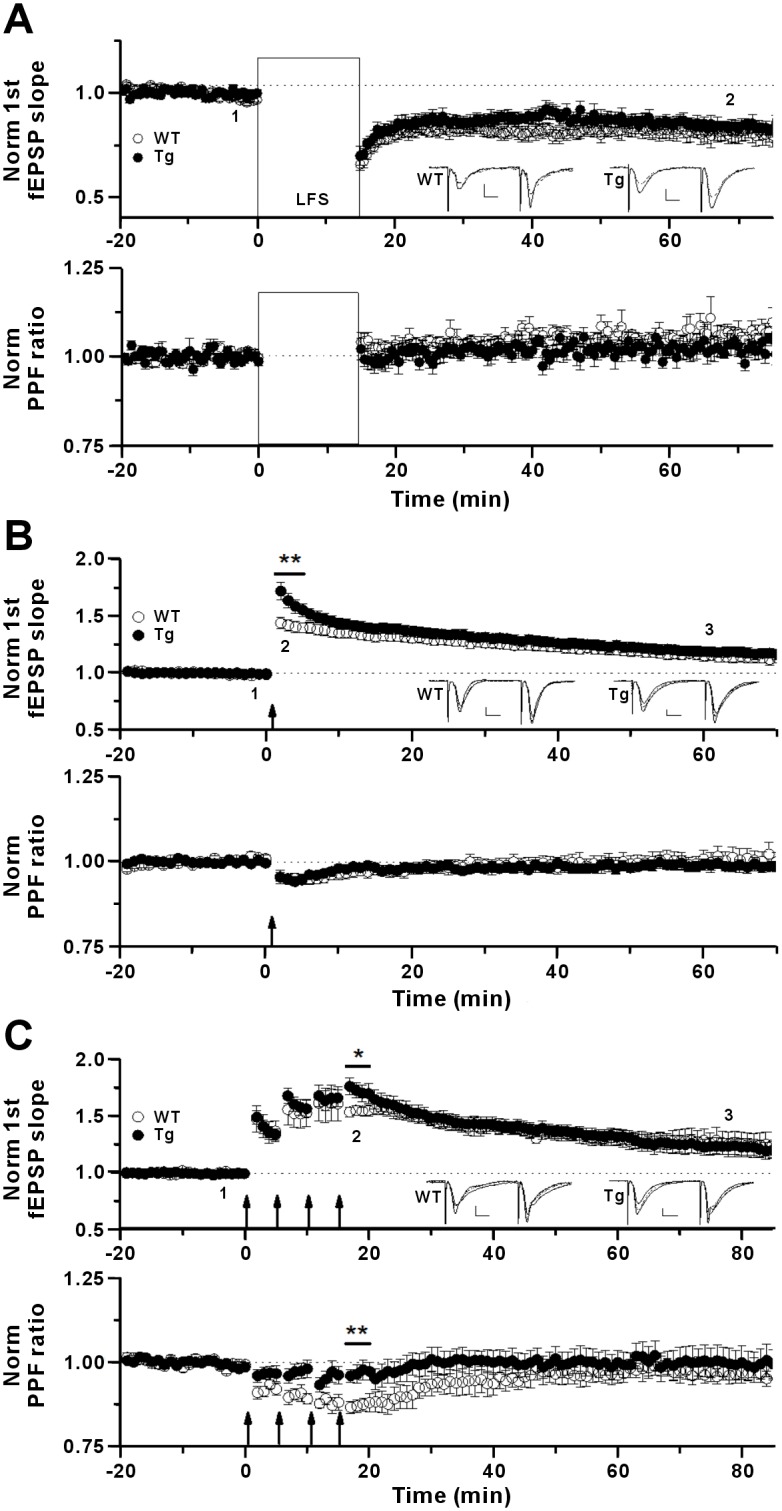
Normal fEPSP-LTD and transient increment of early LTP in young IP3K-A Tg mice.(A), LFS-induced LTD. Upper plot, LTD was induced by LFS protocol (1 Hz, 900 pulses) at the CA1 dendritic region of the hippocampal slice. The slope of fEPSP was 81.1 ± 1.5% (WT, n = 10 slices, 4 mice) and 84.0 ± 1.0% (Tg, n = 10, 4) at 60–65 min on the time axis (p = 0.11). Inlet traces are sample traces measured at baseline (1, thin line) and at 65 min (2, dashed line), respectively. Scale bars: 0.5 mV, 8 msec. Lower plot shows the normalized PPF ratio of the fEPSP slopes. PPF was measured at 60 to 65 min after induction of LTD (WT, 1.06 ± 0.80E-2; Tg, 1.02 ± 0.79E-2). (B), Single theta-burst induced LTP. Upper plot, LTP was induced with a single theta-burst protocol. Significant difference was observed immediately for 2–6 min after the theta-burst protocol (2, bar): WT, 141.5 ± 2.1%, n = 15; Tg, 160.6 ± 2.8%, n = 20; **p < 0.001. At 58–62 min (3), WT, 115.9 ± 2.0%; Tg, 118.9 ± 1.9% of baseline; p = 0.28. Inlet traces are sample traces indicating baseline (1, thin line), early peak (2, thick line) and late phase (3, dashed line). Scale bars for all sample traces: 0.5 mV, 8 msec. Lower plot shows the normalized PPF ratio of the fEPSP slopes. At 2–6 min, WT, 0.95 ± 0.62E-2; Tg, 0.95 ± 0.60E-2. At 58–62min, WT, 1.00 ± 0.98E-2; Tg, 0.99 ± 0.50E-2. (C), Four theta-burst induced LTP. LTP was induced with four theta-burst protocol. Significant difference was observed immediately after the theta-burst protocol (2, bar): WT, 155.0 ± 2.3%, n = 6; Tg, 169.1 ± 4.2%, n = 8; p = 0.027. At 78–82 min (3), WT, 125.3 ± 4.5%; Tg, 123.5 ± 3.1% of baseline; p = 0.74. Inlet traces are sample traces indicating baseline (1, thin line), early peak (2, thick line) and late phase (3, dashed line). Scale bars: 0.5 mV, 8 msec. Lower plot shows the normalized PPF ratio of the fEPSP slopes. At 17–20 min (2), WT, 0.87 ± 0.012; Tg, 0.94 ± 0.014; **p = 0.002. At 78–82 min (3), WT, 0.97 ± 0.011; Tg, 0.99 ± 0.021.